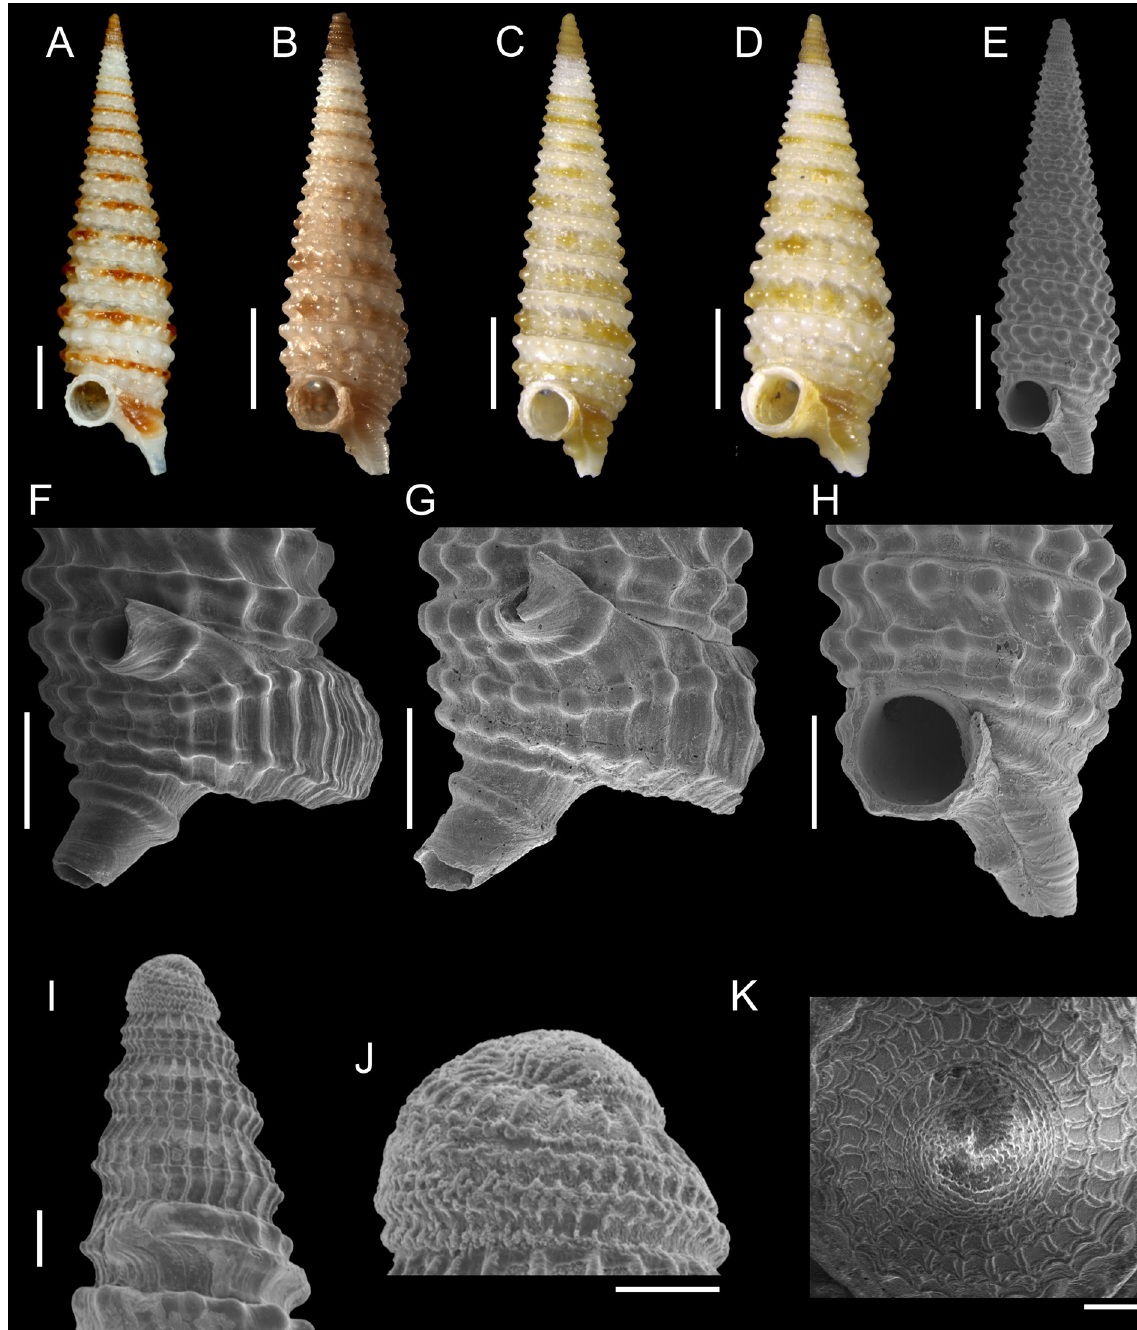
Fig. 89. Iniforis pseudothomae Rolán & Fernández-Garcés, 1993. A . Holotype, MNCN 15.05/6820. B . IBUFRJ 19585, 4.58 mm. C . MNRJ 31517*, 5.05 mm. D . MNRJ 32973*, 4.60 mm. E, G–H . Same shell as B. F, K . Same shell as C. I–J . MNRJ 18303. Scale bars: A–E = 1 mm; F–H = 500 µm; I, K = 100 µm; J = 50 µm. Photo credits A: Rafael Araujo